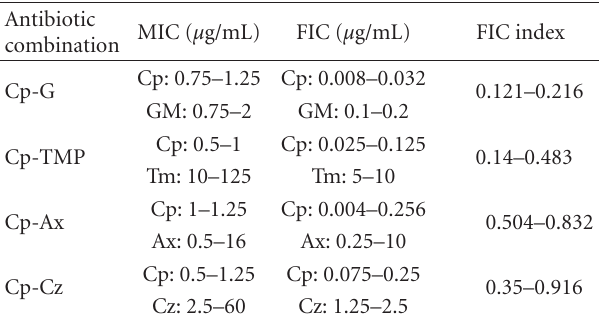
Table 1: Interaction of Cp (ciprofloxacin) in combination with G (gentamicin), trimethoprim (TMP), amoxicillin (Ax) and cefazolin (Cz) against S. enterica serovar Typhi